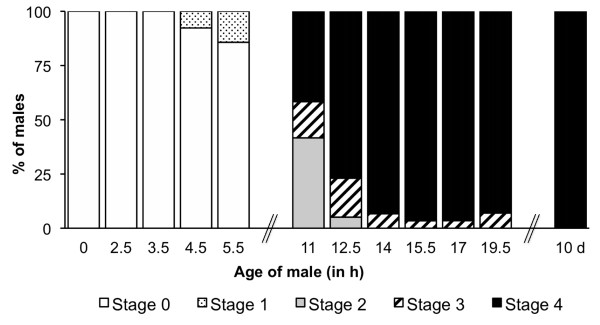
Genitalia rotation over time. Percentage of laboratory-reared males with the terminalia rotated in the different stages as a function of age.